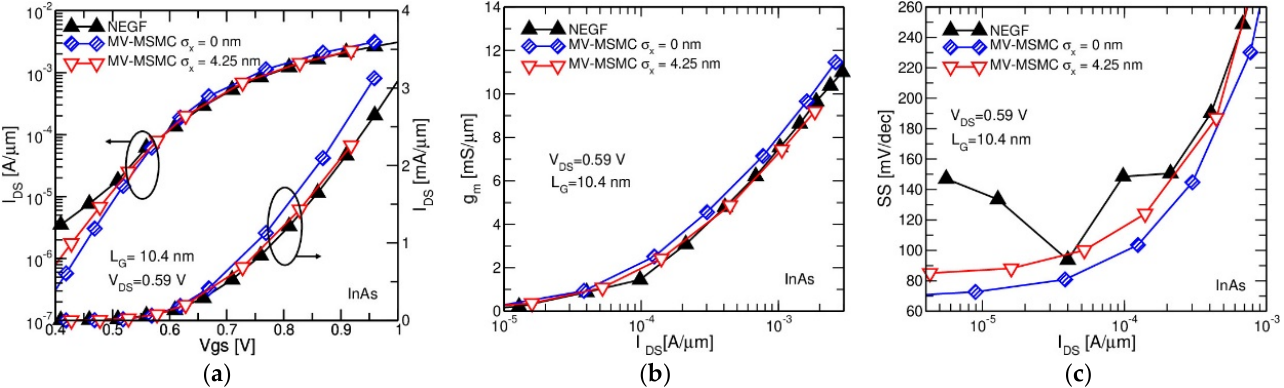
Figure 8. Comparison of ( a ) g m and ( b ) SS between NEGF (ascending triangles) and MV–MSMC simulations using σ = 0 nm (diamonds) and σ = 4.25 nm (descending triangles) for an InGaAs n-MOSFET with L G of 8.3 nm. V DS is 0.59 V. MV–MSMC and NEGF were run over the same voltage range, resulting in different current ranges in the x -axis of the two plots. Luckily, the same value works fine for InAs as well, as demonstrated by the match between MV–MSMC and NEGF for the 10.4 nm device in Figure 9. In this latter case, the off-current was not matched to highlight that the NEGF shows a contribution of band-to- band tunneling (due to the smaller bandgap of InAs compared to In 0.53 Ga 0.47 As) that is not included in the MV–MSMC. The values of the on-current from NEGF and MV–MSMC are summarized in Table 1.